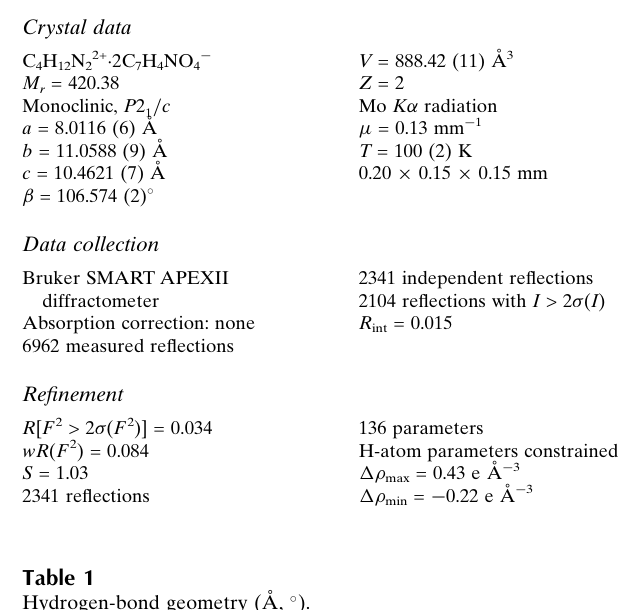
Hydrogen-bond geometry (A˚ , (cid:3) ). D —H (cid:1)(cid:1)(cid:1)